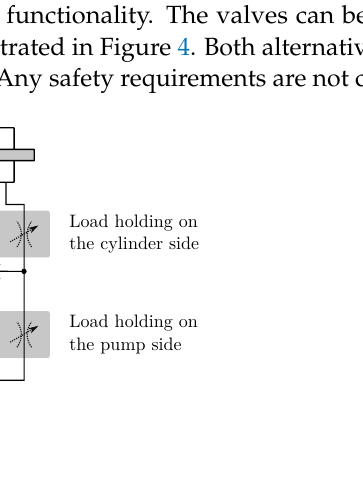
Figure 4. Alternative placements for load-holding functionality in closed